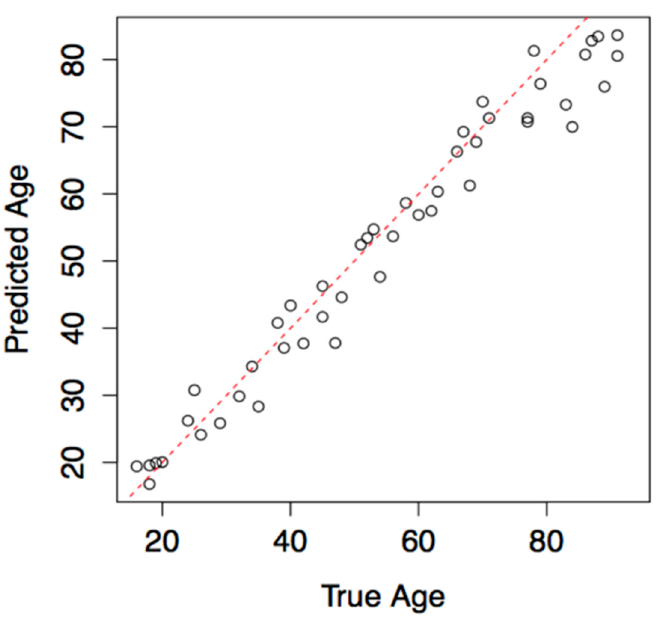
Figure 14. Results of cross validation ( n = 50, female).